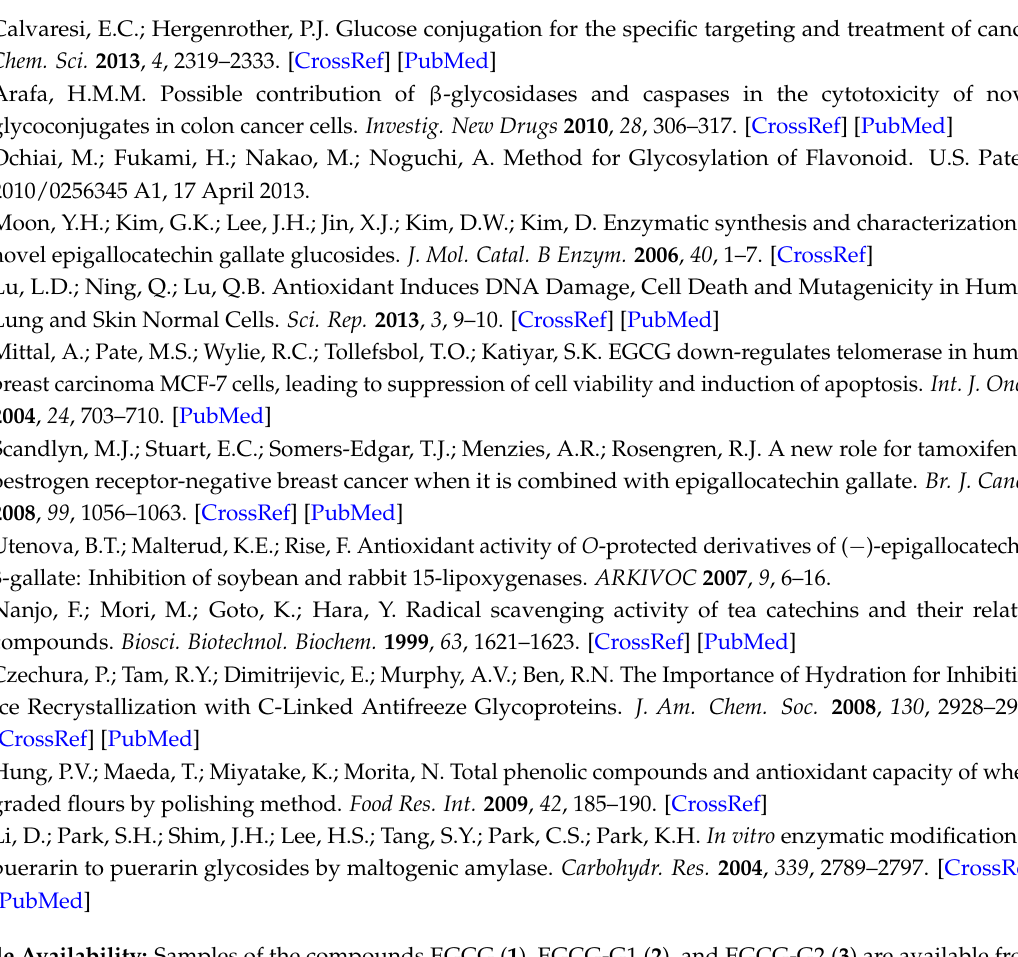
Sample Availability: Samples of the compounds EGCG ( 1 ), EGCG-G1 ( 2 ), and EGCG-G2 ( 3 ) are available from the